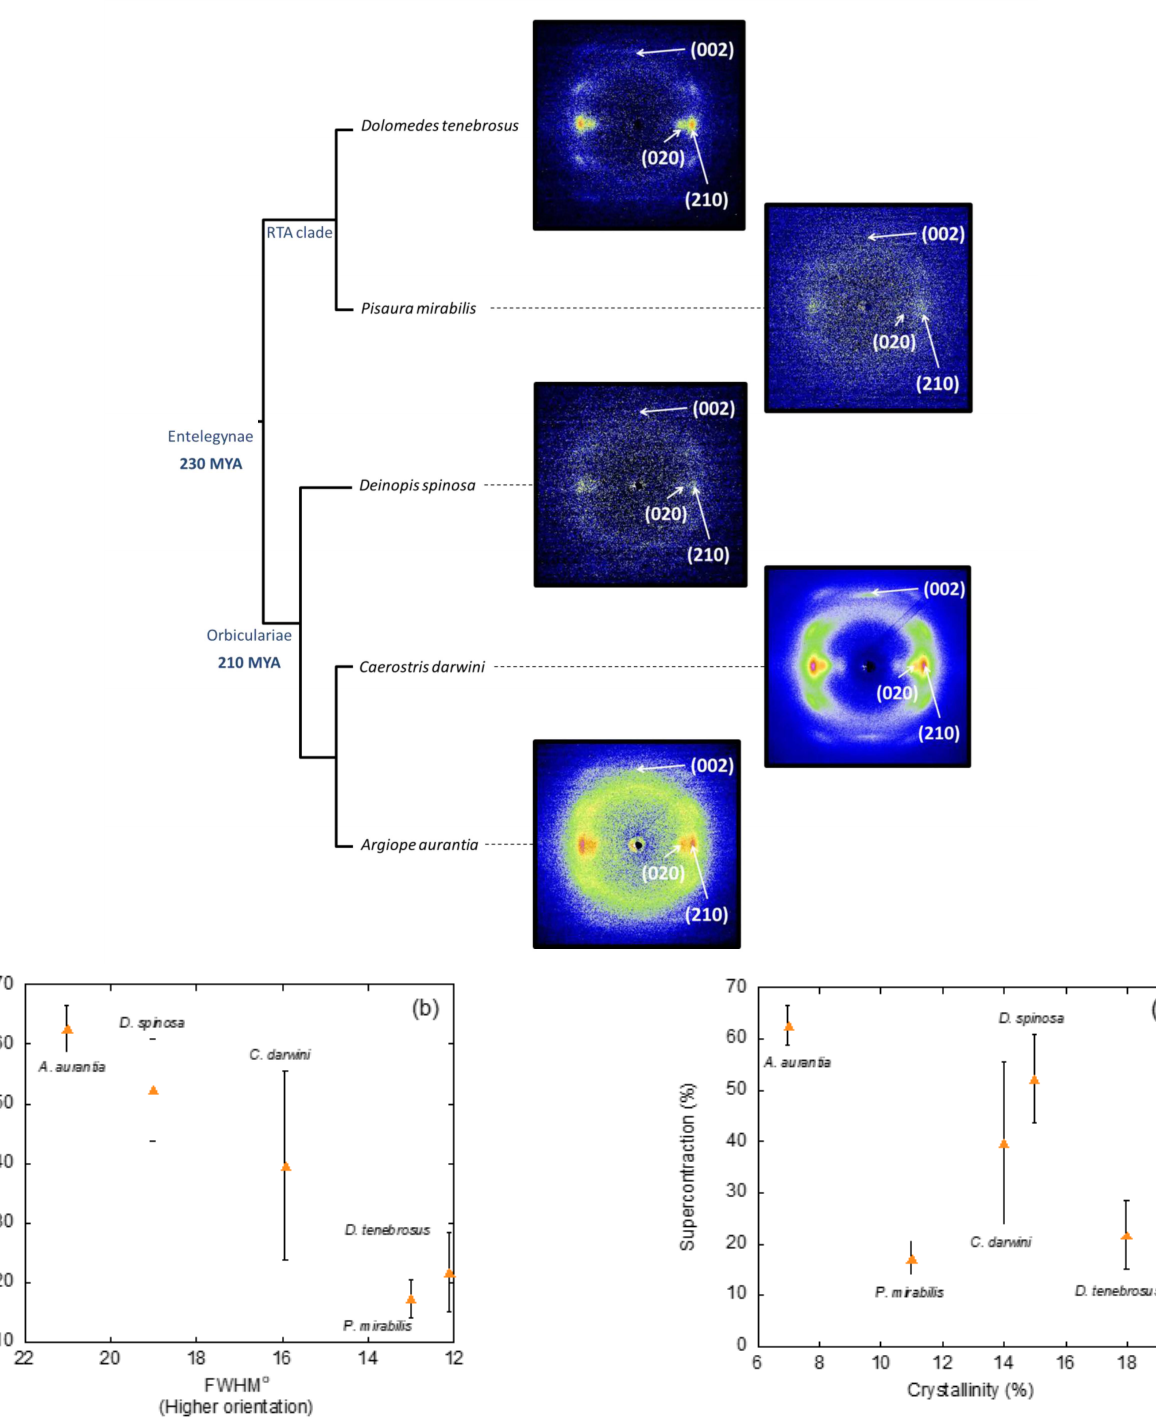
Figure 3. ( a ) X ray diffraction patterns of individual spider silk fibers of selected representatives of the Entelegynae suborder after being subjected to maximum supercontraction. ( b ) Relationship between the extent of supercontraction and the orientation of the nanocrystals with respect to the macroscopic axis of the fiber (measured as the full width at half maximum (FWHM) of the diffraction spot along the azimuthal direction) for the different species. ( c ) Relationship between the extent of supercontraction and the crystallinity of the fibers for the different species. The experimental details may be found in the corresponding references by the authors cited in the main text.